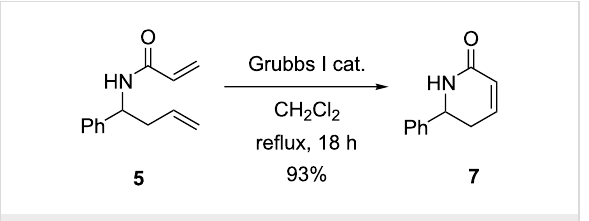
Scheme 4: Ring-closing metathesis reaction of diene 5 to yield dihydropyridone 7 [20-23].